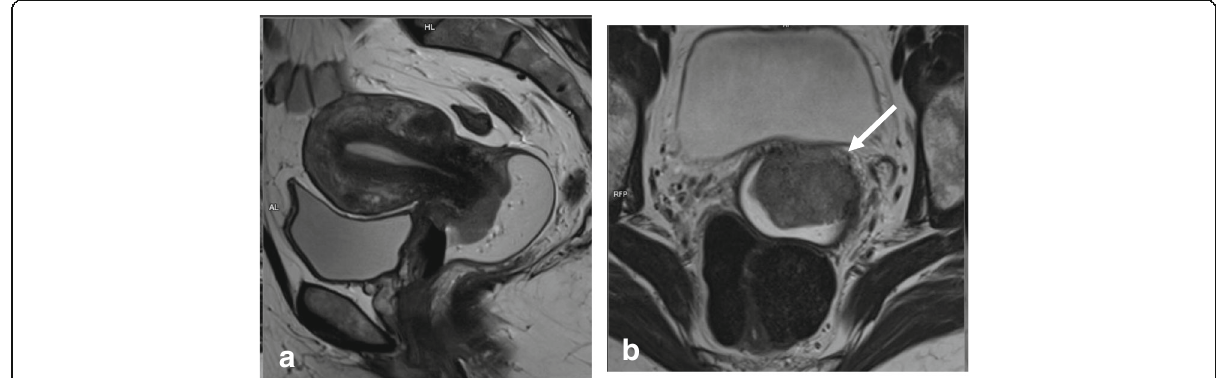
Fig. 13 a , b Sagittal and axial oblique T2WI with vaginal gel, revealing a cervical carcinoma with vaginal infiltration, seen as disruption of the hypointense anterior wall (arrow)